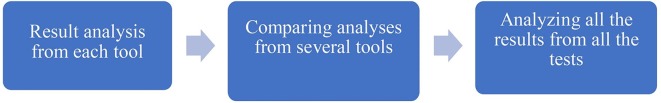
Steps of each tool analysis.